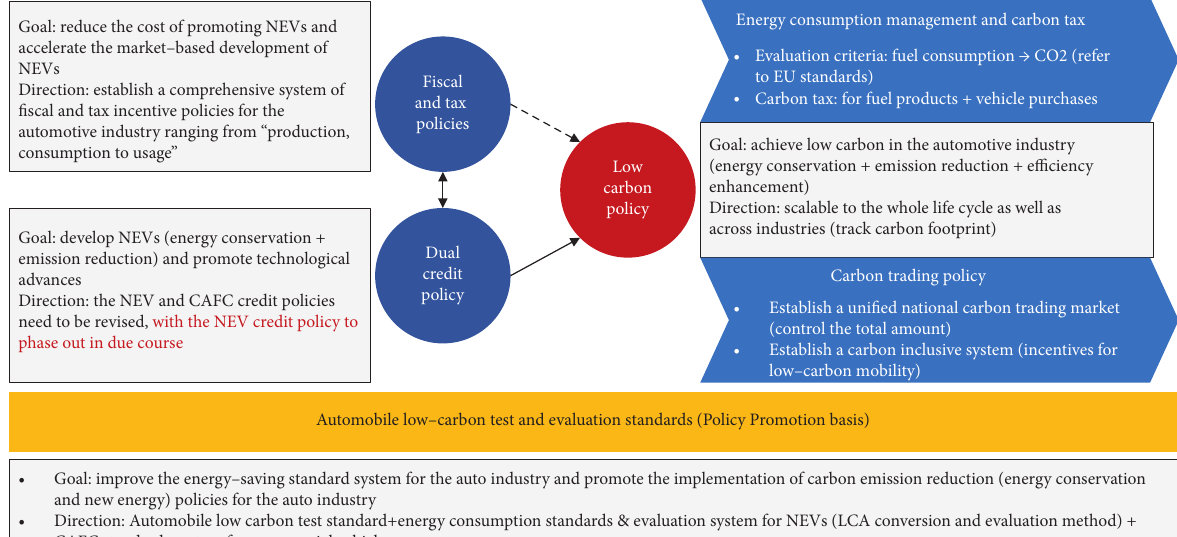
Figure 7: The low-carbon policy, regulation, and standard system with carbon trading policy as the